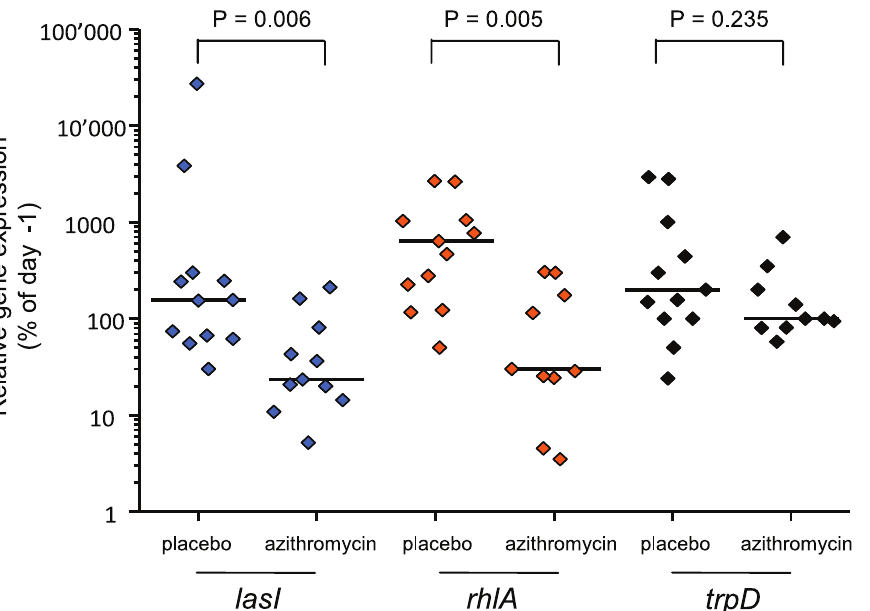
Figure 2. Inpatient QS-inhibition in azithromycin-treated patients. In patient QS-gene expression was determined as described. Tracheal aspirates from both day 2 1 and day x with bacterial RNA of adequate quality were available for twelve placebo and eleven azithromycin patients. Expression of QS-circuit gene lasI , QS-target gene rhlA and QS-independent gene trpD measured in tracheal aspirates is shown as the relative value (%) of the last accessible day (Dx) compared to day 2 1 (set as 100%). A horizontal line indicates the median expression levels. P values were calculated using Mann-Whitney tests.